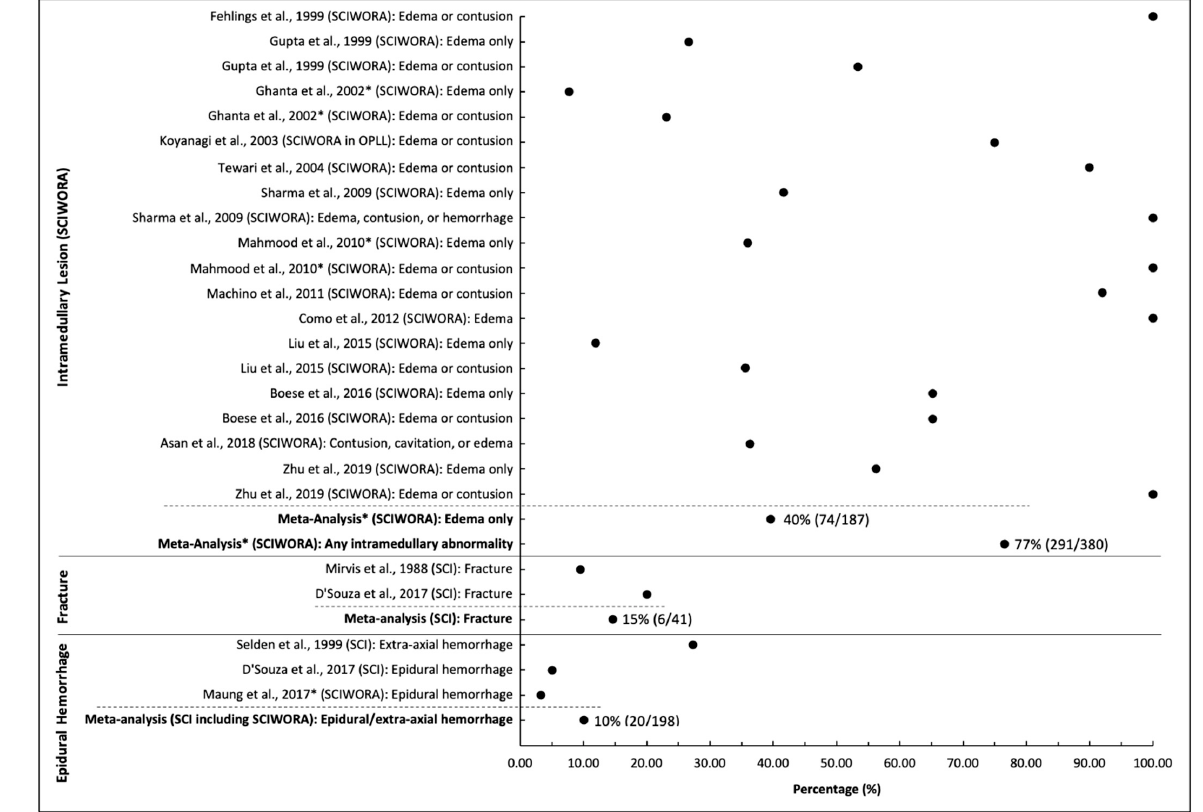
Figure 4. Frequency of Epidural Hemorrhage, Fracture, and Intramedullary Lesions (SCIWORA) on MRI in patients with acute spinal cord injury. * Studies that include pediatric patients (<16) or unspecified age range.